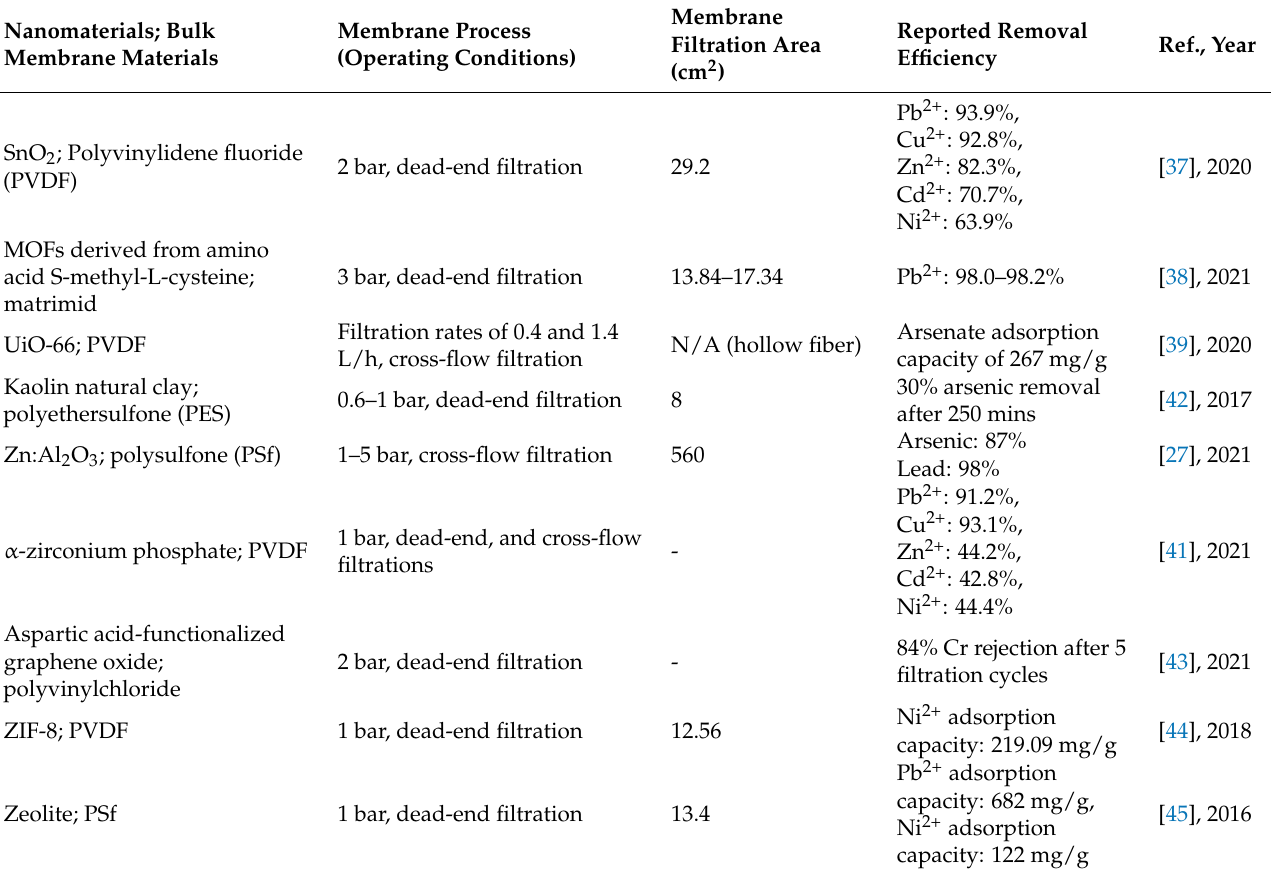
Table 1. A summary of emerging materials adopted to prepare MMMs for heavy metal removal in water. The removal efficiency is reported based on the rejection of a heavy metal ion or the adsorption capacity, depending on what was reported in the